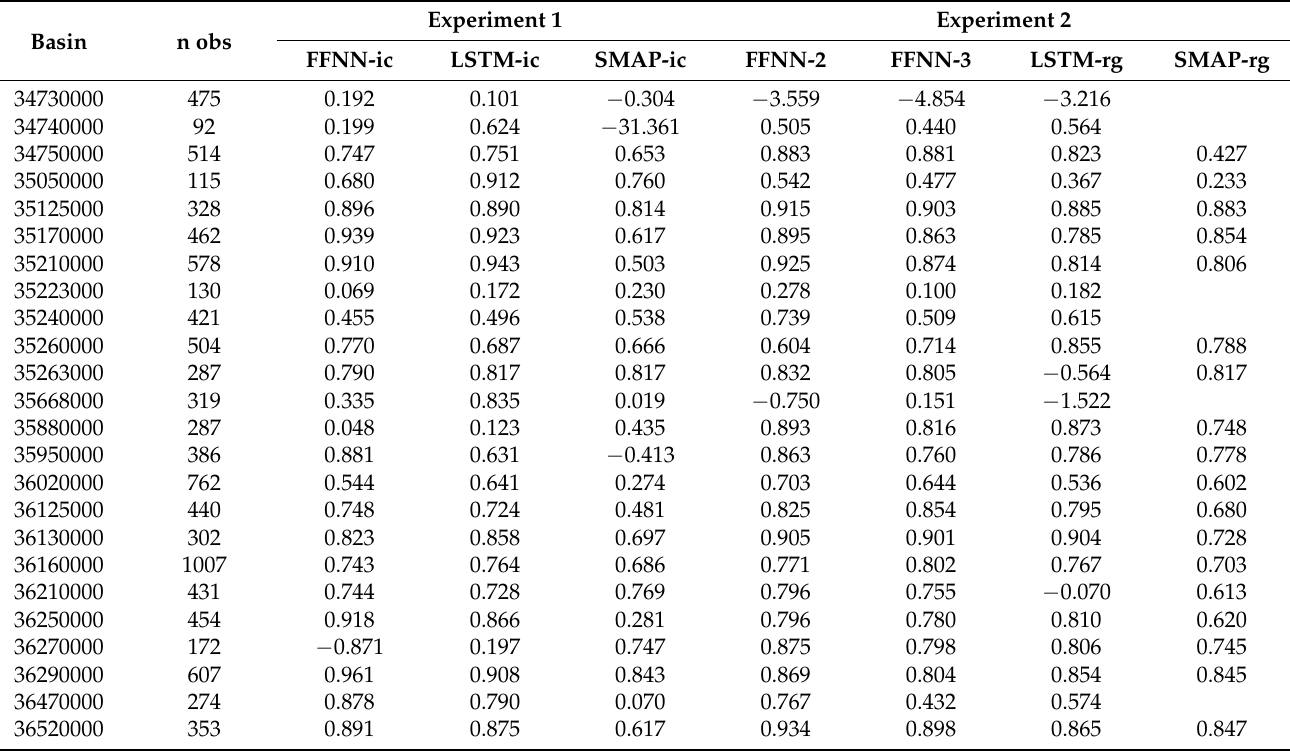
Table 3. Models’ performances per basin.